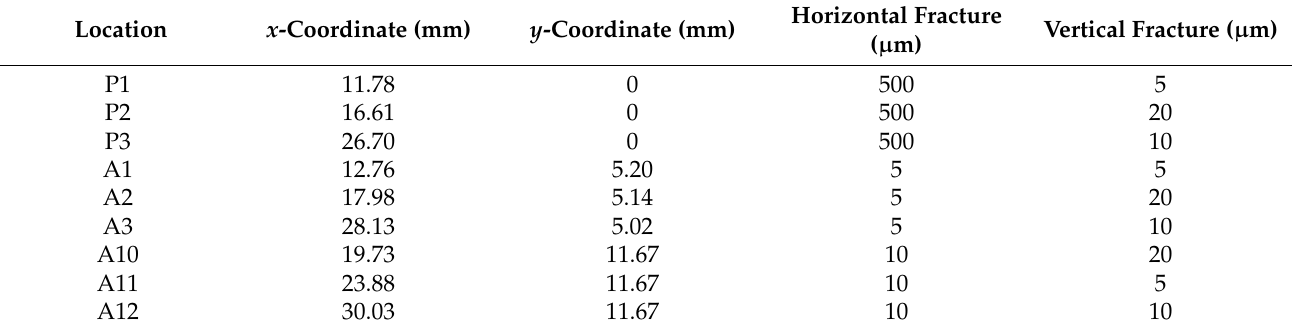
Table 2. Coordinates of imaged intersections.